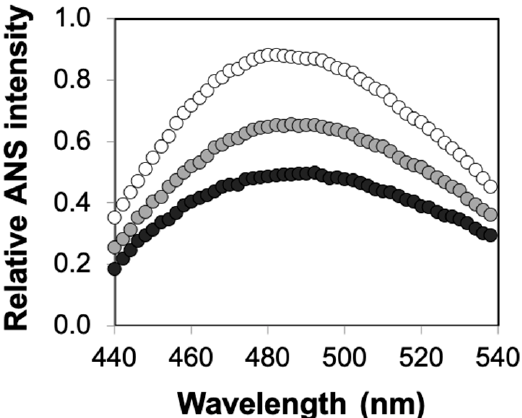
Figure 5. Structural stability of HRP encapsulated in agarose gels. Relative 8-anilino-1- naphthalenesulfonic acid (ANS) fluorescence intensities for solution-phase enzyme (white) and enzyme encapsulated in 0.5% agarose (gray) and 2% agarose (black) at 60 °C. Relative fluorescence intensities for the agarose–HRP formulations are reported after subtraction of the spectra of the corresponding agarose gels containing no enzyme. Each data point represents an average of triplicate measurements, with standard error <15%.